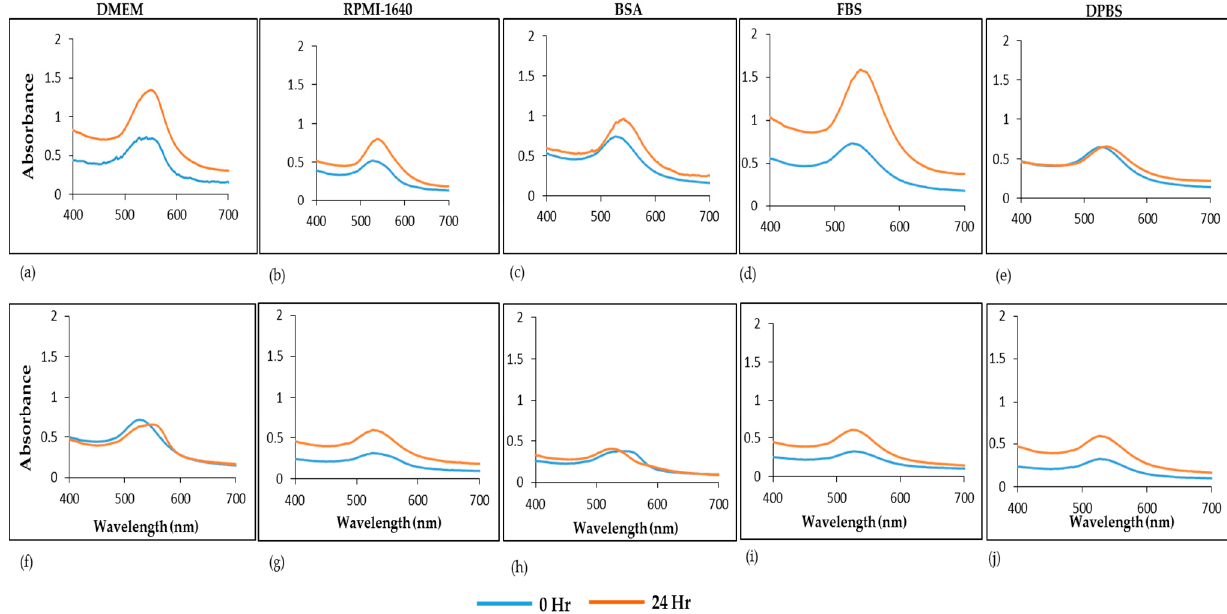
Figure 5. Stability of AuNPs in biological media at 0 and 24 h incubation at 37 °C. UV-Vis spectra of HB-AuNPs ( a – e ) and MGF-AuNPs ( f – j ) in DMEM ( a , f ), RPMI ( b , g ), BSA ( c , h ), FBS ( d , i ) and DPBS ( e , j ).